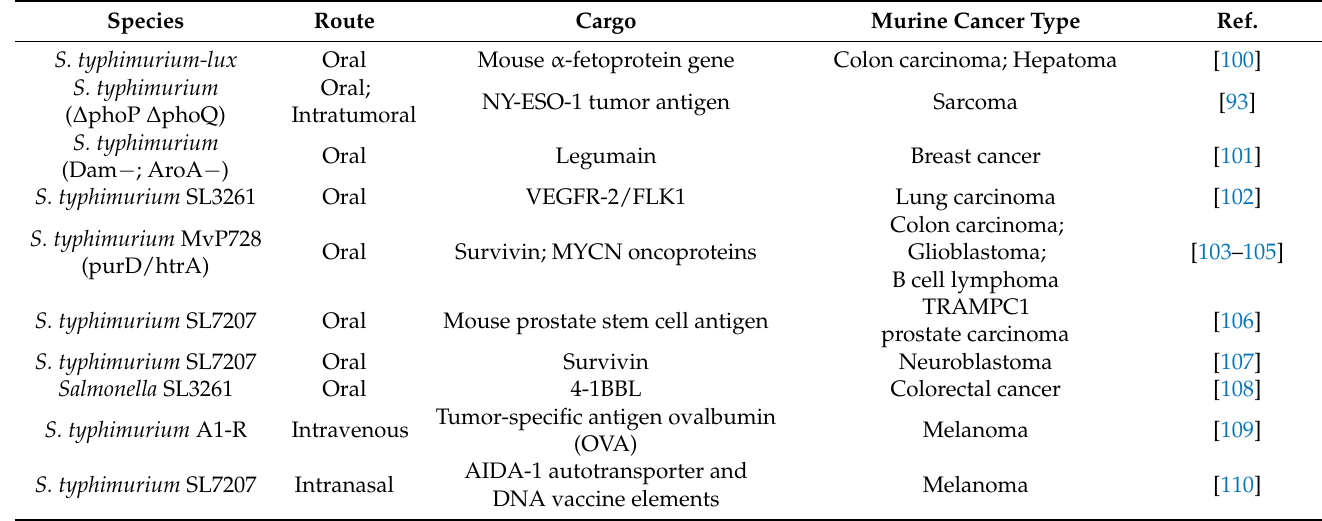
Table 2. Salmonella -based cancer vaccine